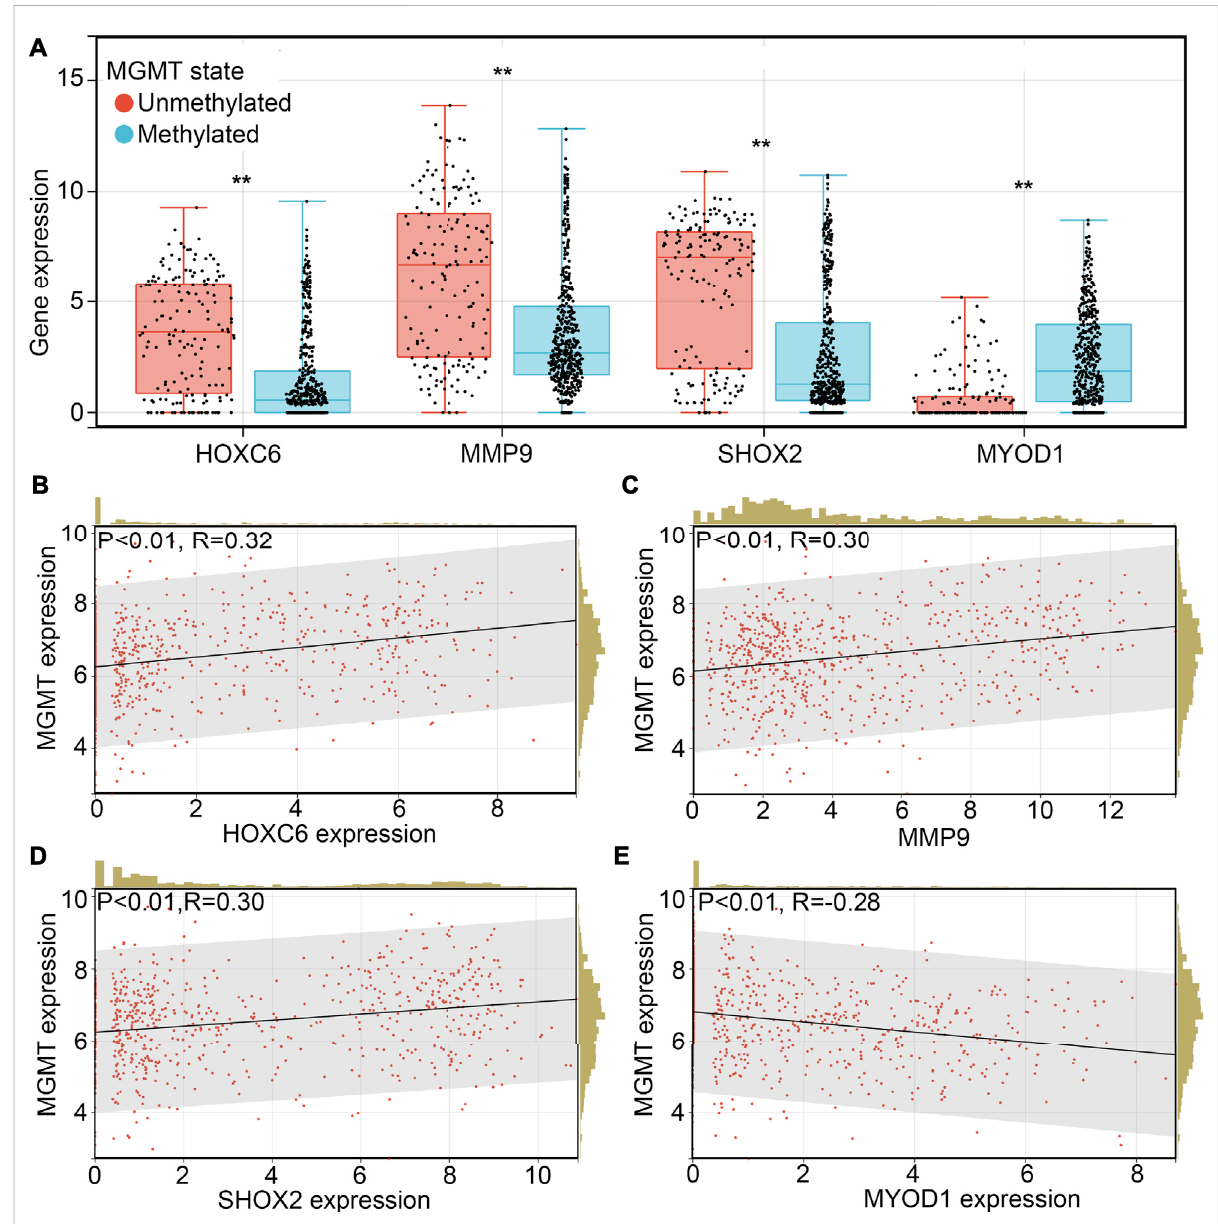
FIGURE 7 SHOX2 was associated with MGMT expression. (A) Expression of HOXC6, MMP9, SHOX2 and MYOD1 in glioma tissues with promoter methylationandpromoterunmethylation.Co-expressionrelationshipbetweenHOXC6 (B) ,MMP9 (C) ,SHOX2 (D) andMYOD1 (E) betweenMGMTin glioma tissues. **, p <